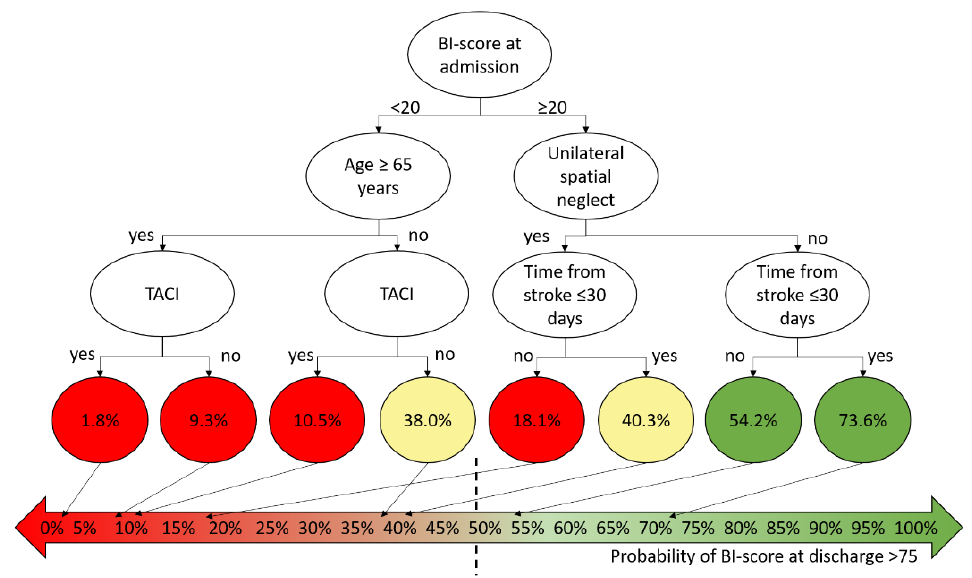
Figure 1. The classification tree obtained by cluster analysis on the analyzed sample.